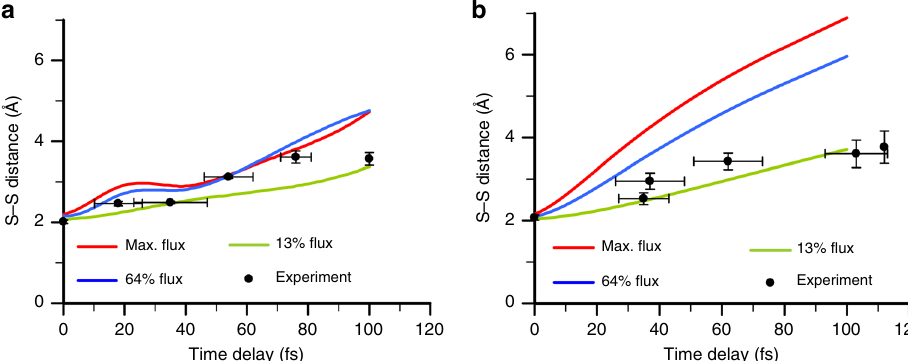
Fig. 4 Theoretical analysis of sulfur displacements as a function of pump probe delay. a Average distance between sulfur atoms of a S – S bridge as a function of pump-probe time delay in thaumatin, predicted by the XMDYN molecular dynamics simulation. The red, green and blue curves represent the S – S distances for the experimental total nominal fl uence (pump and probe combined), Ϝ max = 7.0 × 10 12 photons µ m − 2 , Ϝ med = 4.4 × 10 12 photons µ m − 2 (64% of Ϝ max ) and Ϝ low = 8.8 × 10 11 photons µ m − 2 (13% of Ϝ max ), respectively, whereas the black curve with error bars represents the experimentally measured S – S separation with delay uncertainty and distance error included (see Supplementary Discussion). b Average distance between sulfur ions in a S – S bridge in lysozyme, as a function of pump-probe time delay, predicted by the hybrid continuum model. For direct comparison between the two models, the variations in the ionic charges in the hybrid model were matched to the corresponding XMDYN results. The good agreement between the two models con fi rms the importance of plasma electron screening and ion caging effects. The error bars of the experimental values correspond to the standard deviations of the XTCAV-derived time-delay values ( x -axis) and give the standard deviation of the distribution ( y